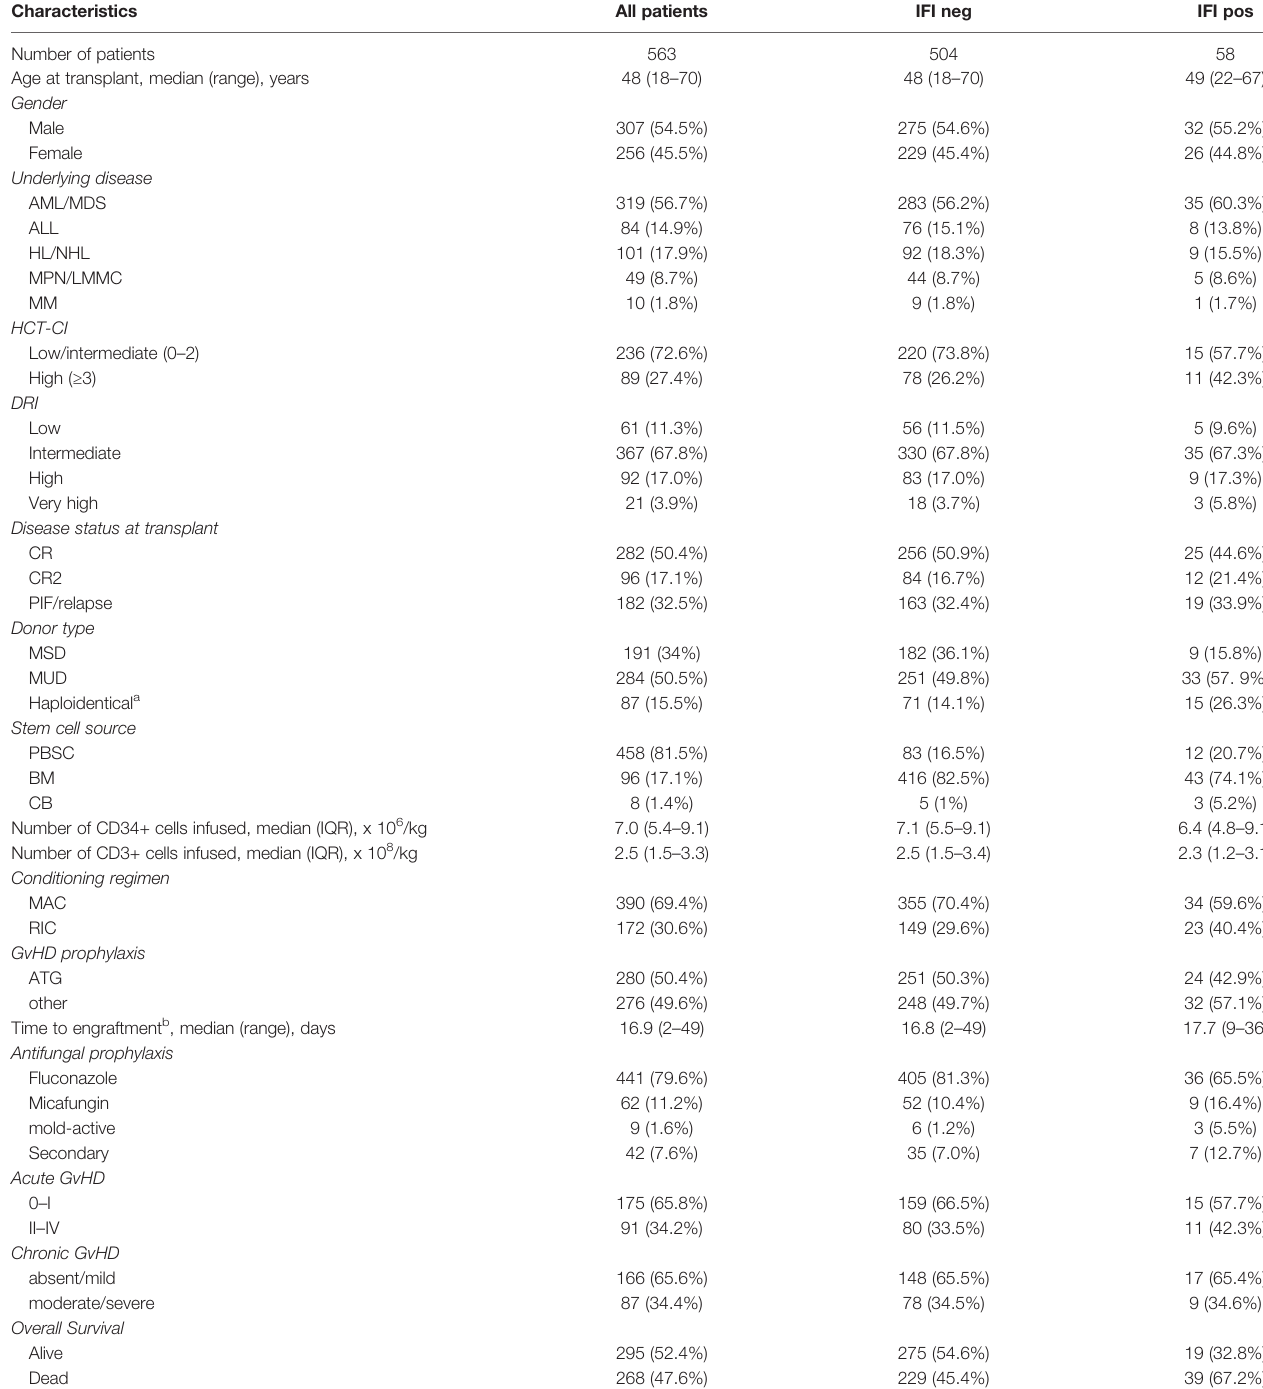
TABLE 1 | Main patients ’ and transplants ’ characteristics of the whole cohort and strati fi ed by IFI.